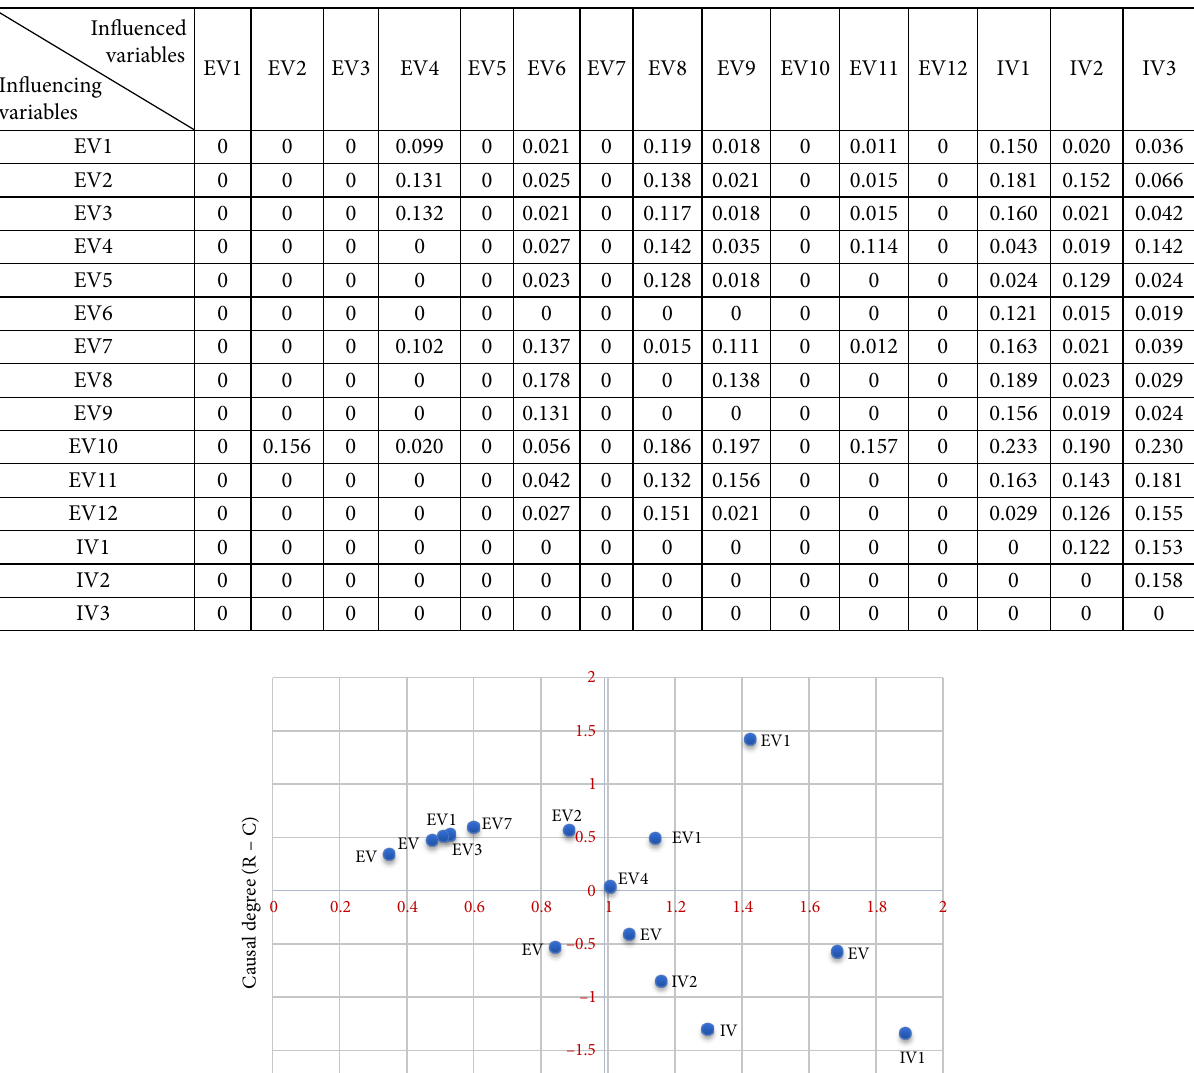
Table 8. Total-relation